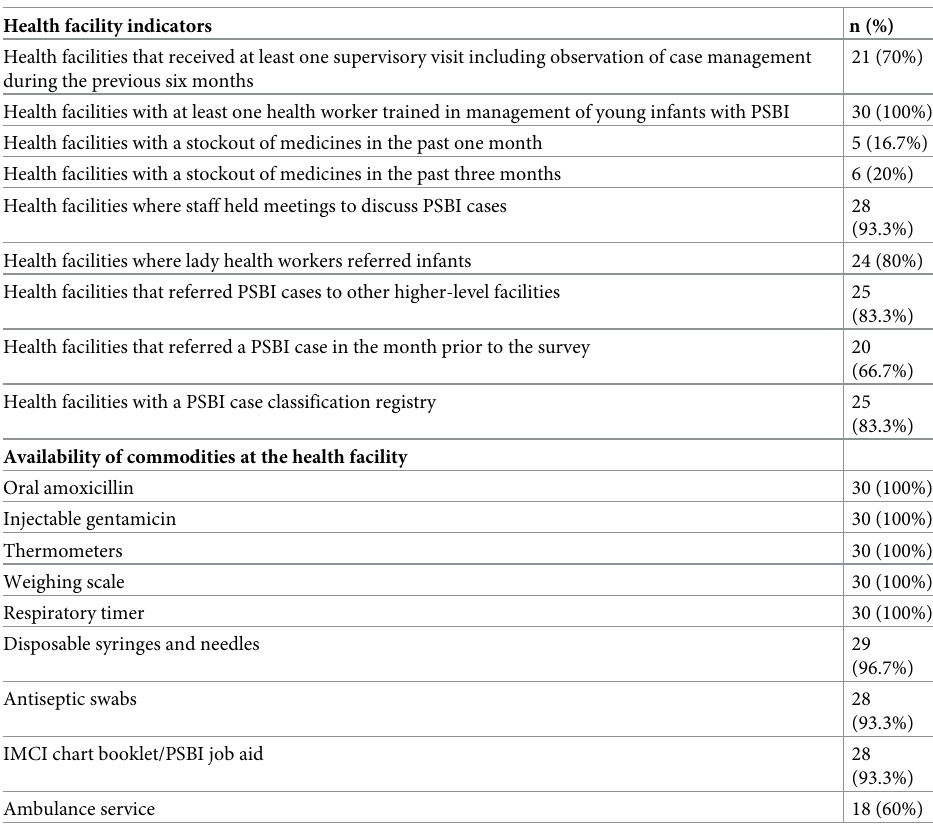
Table 1. Indicators for health system support, availability of commodities and referral mechanism at health facili- ties (n =